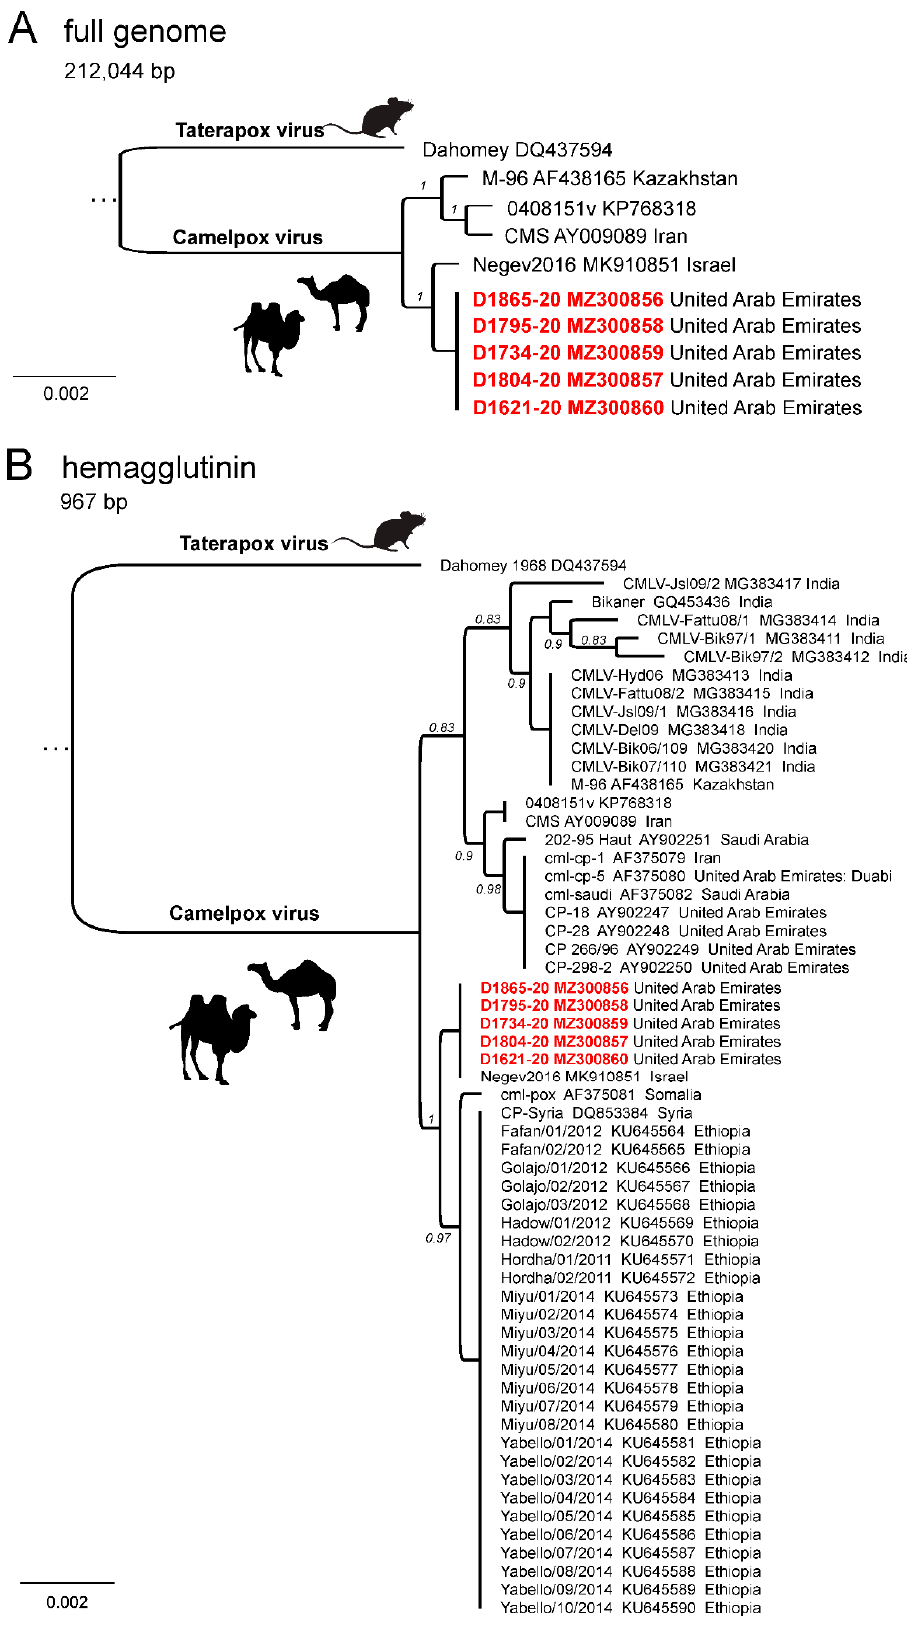
Figure 4. Maximum likelihood phylogeny based on the complete genome ( A ) and the partial hemagglutinin gene ( B ) sequences of Camelpox virus genomes from the outbreak in United Arab Emirates in comparison to available reference sequences. Taterapox virus is used as an